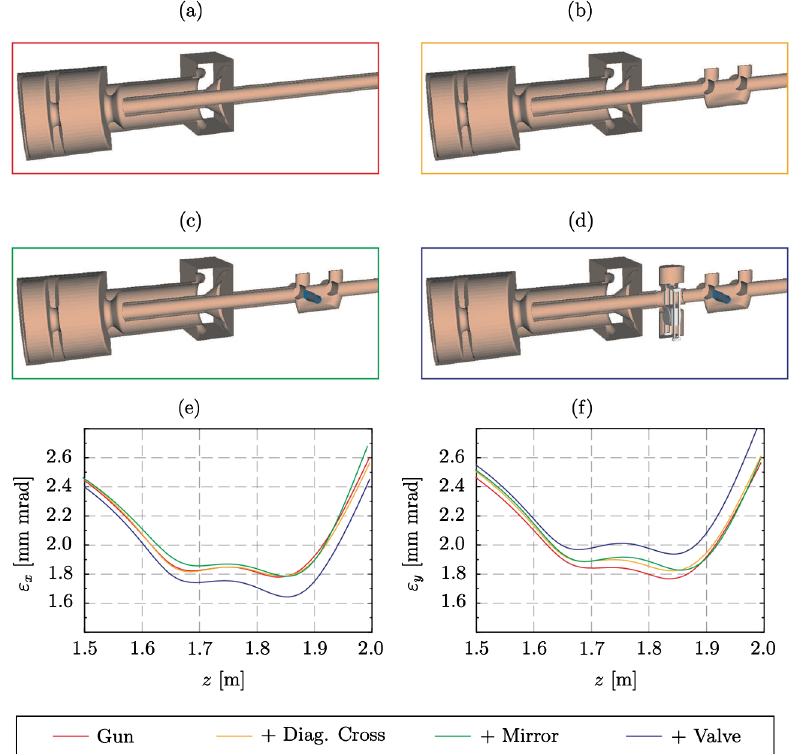
FIG. 14. Models and results of the PITZ rf gun design study. In (a) to (d) the CAD models of the simulated structures are shown. The horizontal and vertical emittances around the position of their minimum are plotted in (e) and (f), respectively. The colors of the curves correspond to the outline color of the models above. While " model depicted in